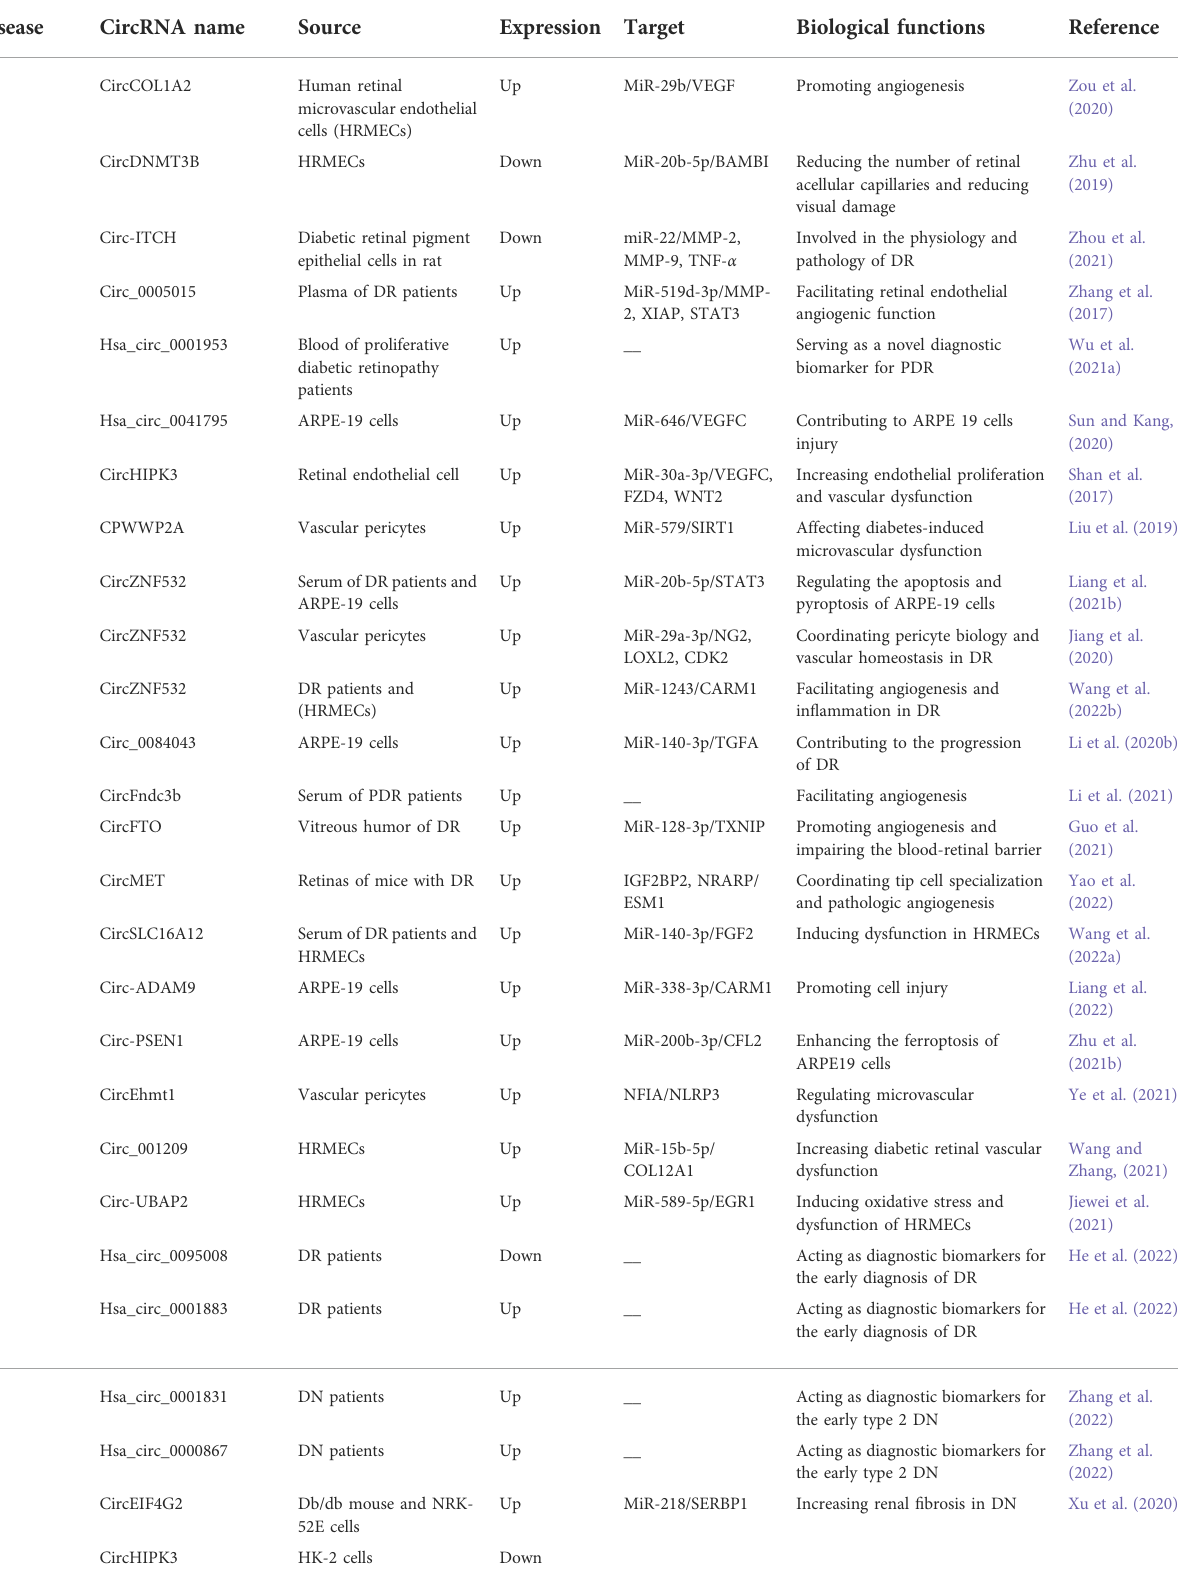
TABLE 1 The expression and roles of circRNAs in diabetic complications.